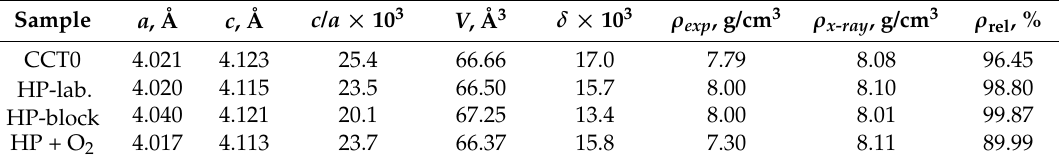
Table 1. Parameters = a and c ; volume = V ; degree of distortion = c / a ; for tetragonal cells, homogeneous strain parameter = δ ; experimental = ρ exp . ; X-ray = ρ x − ray ; and relative = ρ rel , densities of PCR-13 produced by different methods.